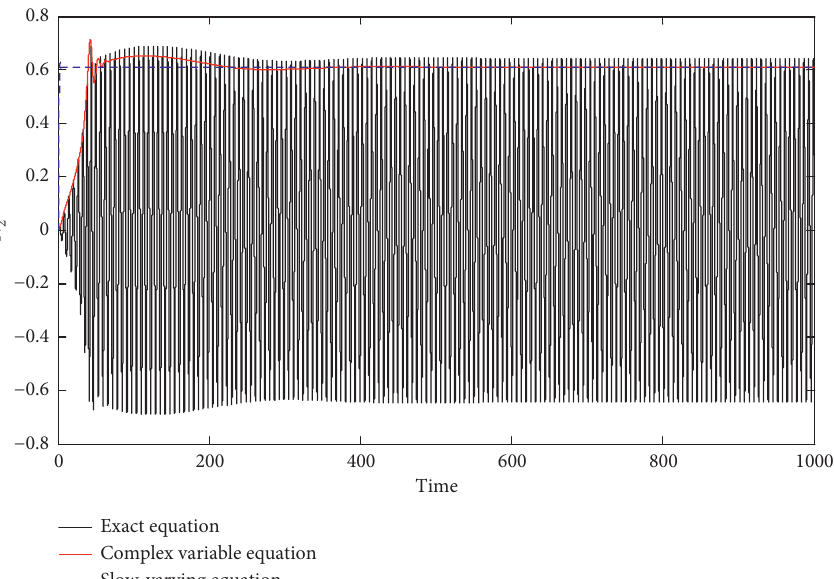
Figure 9: Time-history curves of nonlinear energy sink. The dashed line refers to the steady-state response of the slow-varying equation. � 0 . 8 ; λ � 0 . 3 ; kn � 5 ; f � 1. System parameters: λ 1 2